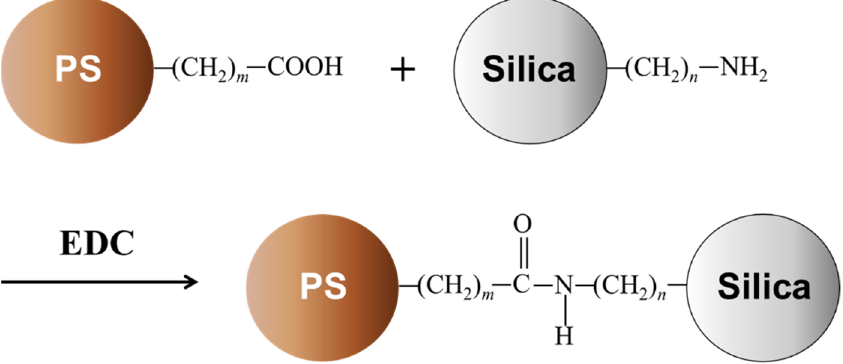
Figure 1. Reaction scheme between a carboxyl-activated polystyrene (PS) magnetic particle and an amino-coated silica particle (both from Spherotech ® ). m and n are natural numbers between 2 to 8, according to vendor’s information.